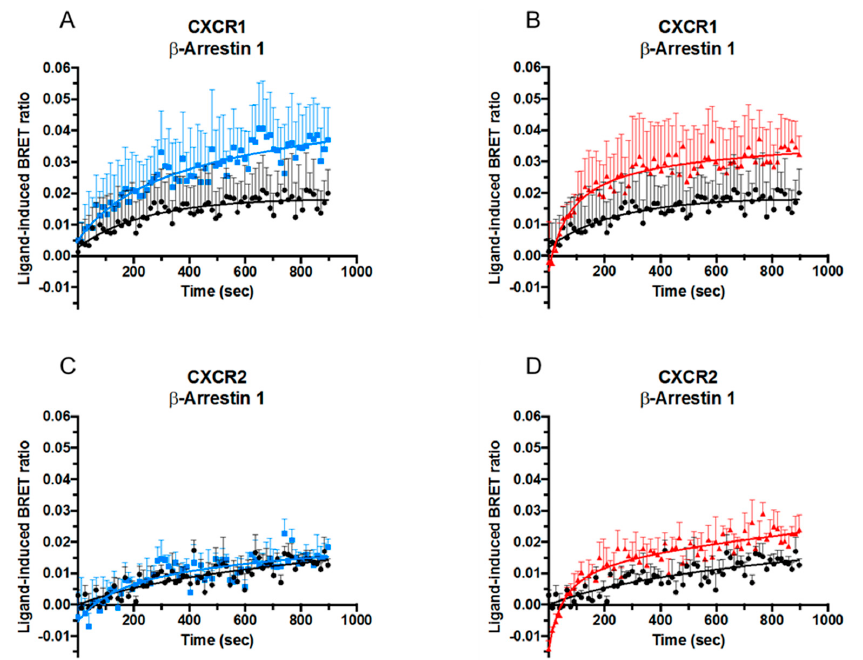
Figure 3. Effects of NH 2 -terminal processing on CXCL8-induced β -arrestin 1 recruitment. Kinetic BRET measurements of β -arrestin 1 recruitment to CXCR1 ( n = 3) ( A , B ) and CXCR2 ( n = 4) ( C , D ) in transfected HEK-293T cells after stimulation with 100 nM CXCL8(1-77) ● ,[Cit 5 ]CXCL8(1-77) ■ or CXCL8(6-77) ▲ . Results are represented as ligand-induced BRET ratio +SEM. Int. J. Mol. Sci. 2018 , 19 , x FOR PEER REVIEW